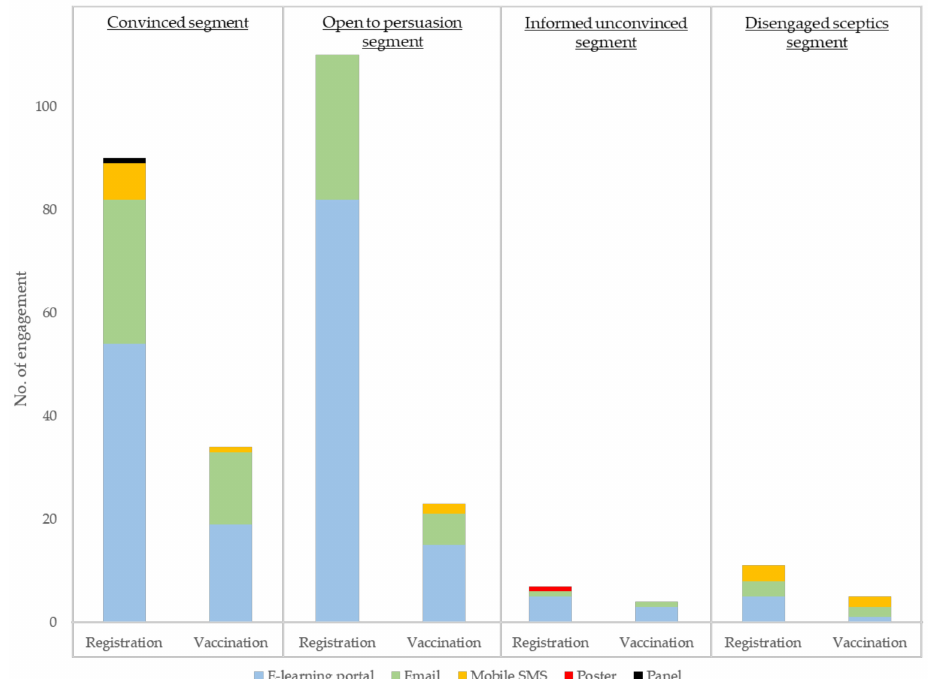
Figure 5. Channel engagement through online and offline channels by student